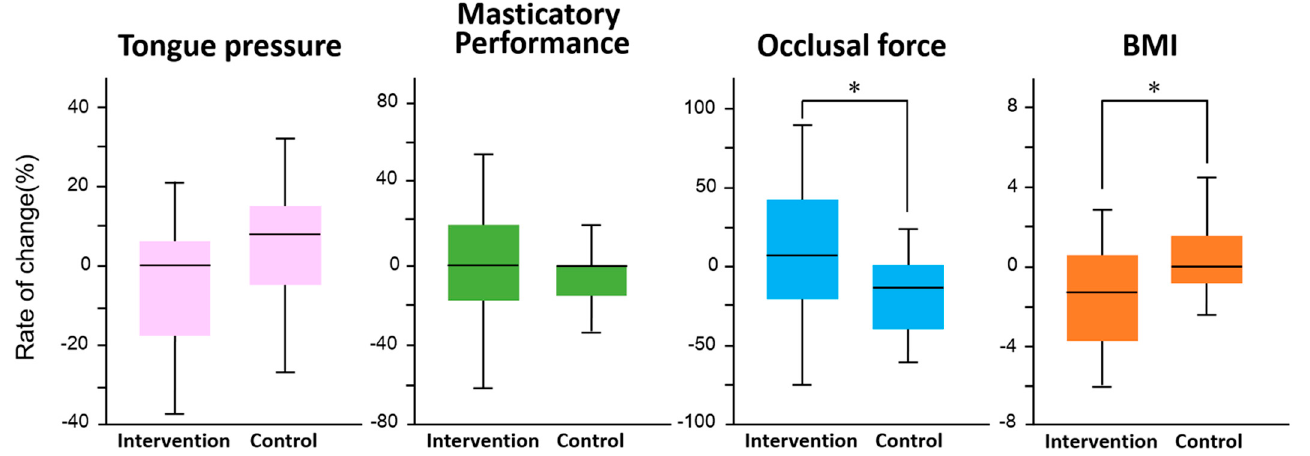
Figure 3. Comparison of rate of change between interval walking training and control groups in each measured item. An analysis of covariance (ANCOVA) was used to compare the intervention and control groups in terms of rate of change in tongue pressure, masticatory performance, occlusal force, and BMI, with the main effects being between-group difference and time, and age as a covariate. *: Significant difference in each measured item by ANCOVA.